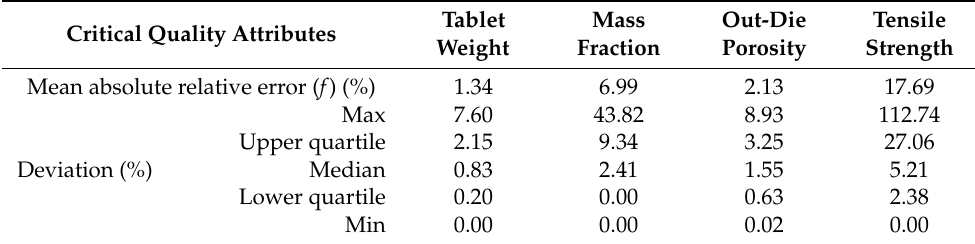
Tablet Mass Out-Die Tensile Weight Fraction Porosity Strength